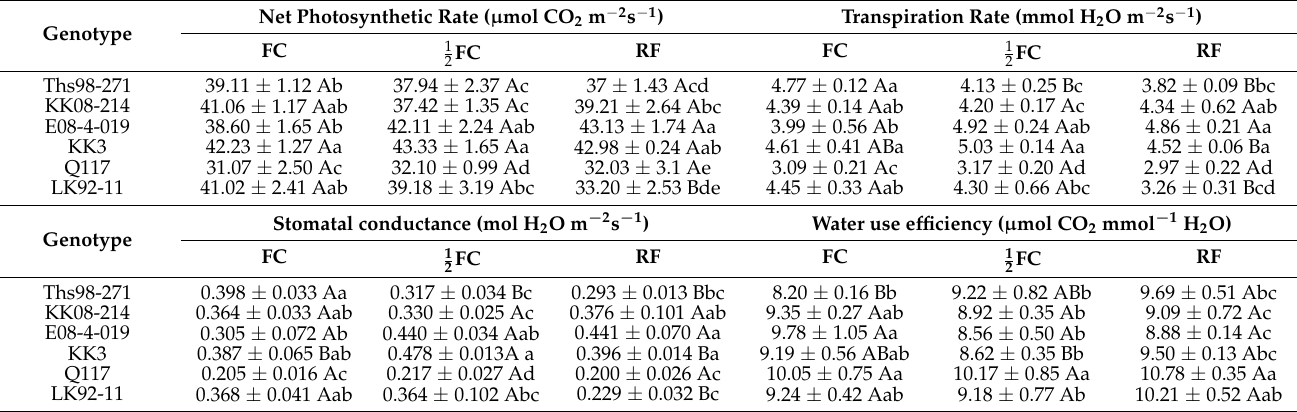
Table 8. Net photosynthetic rate ( A ), transpiration rate ( E ), stomatal conductance ( g s ) and water use efficiency (WUE) of six sugarcane genotypes under recovery conditions (determined six months after planting).